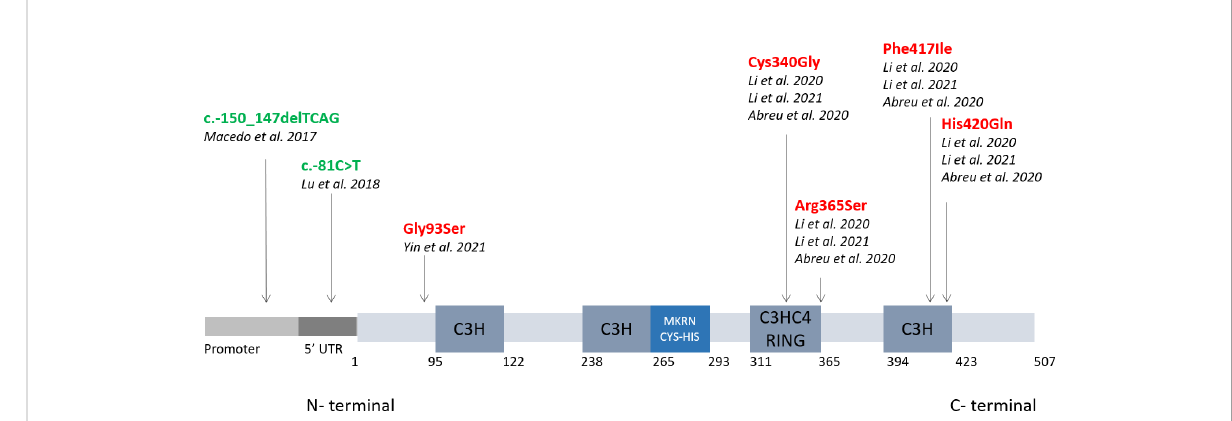
FIGURE 1 CPP-associated mutations compromise the auto-ubiquitination and binding af fi nity of MKRN3. The image shows the structure of the MKRN3 gene, which consists of three zinc fi nger domains (C3H) and one RING fi nger domain (C3HC4). The major mutations tested in functional studies are shown here with a black arrow indicating their location on the MKRN3 protein. Mutations causing defects in MKRN3 expression are shown in green, while in red are shown mutations affecting auto-ubiquitination or binding of MKRN3 to promoters of effector